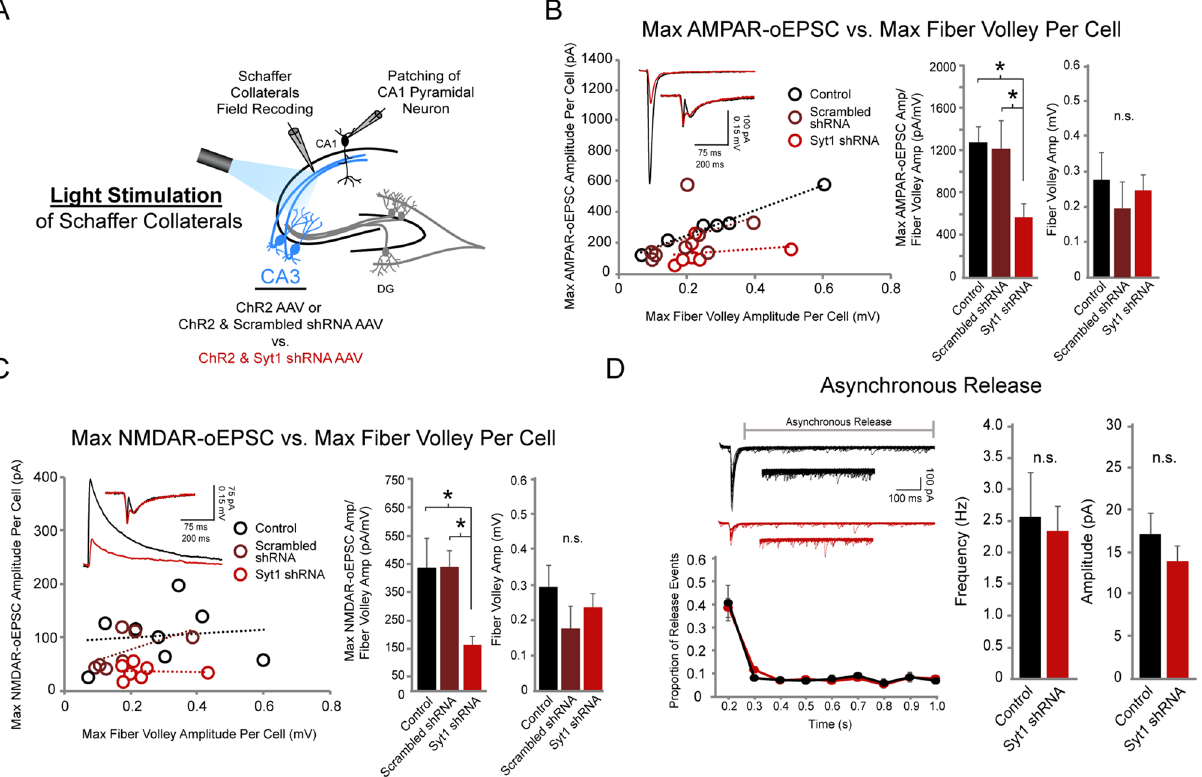
Figure 4. Syt1 knockdown diminishes CA3-CA1 excitatory synaptic transmission with optical stimulation of CA3 pyramidal neurons. ( A ) Schematic illustration of recording setup using optogenetic stimulation. AAV expressing: (1) ChR2 only (control), (2) ChR2 with scrambled shRNA (scrambled shRNA), or (3) ChR2 with Syt1 shRNA were injected into the CA3 region of hippocampal slices. Schaffer collaterals were optically stimulated with blue light. Schaffer collateral field recordings and whole-cell patch recordings of CA1 pyramidal neurons were simultaneously acquired. For ( B )–( D ), Wilcoxon rank sum test was used. * p < 0.05, n.s., not significant. ( B ) (Left) Max AMPAR-oEPSC/FV ratios per cell in control, scrambled shRNA & Syt1 shRNA conditions following optical stimulation. Each point represents the maximum AMPAR-oEPSC/FV amplitude ratio of one cell; measurements from each condition were fitted with a linear regression line. Insets show representative traces from control (black) and Syt1 shRNA (red) conditions. (Center) Averaged and normalized Max AMPAR-oEPSC/FV amplitude ratio in control, scrambled shRNA & Syt1 shRNA conditions (n = 6, 8, 7 respectively, control vs. Syt1 shRNA p = 0.007, scrambled vs. Syt1 shRNA p = 0.0037). (Right) Averaged fiber volley amplitudes in control, scrambled shRNA & Syt1 shRNA conditions (control n = 6, scrambled shRNA n = 8, Syt1 shRNA n = 7, control vs. Syt1 shRNA p = 0.63, scrambled vs. Syt1 shRNA p = 0.46). ( C ) (Left) Maximum NMDAR-oEPSC/FV ratios per cell in control, scrambled shRNA & Syt1 shRNA conditions. Insets show representative traces from control (black) and Syt1 shRNA (red) conditions. (Center) Averaged and normalized NMDAR-oEPSC/FV amplitude ratio in control, scrambled shRNA & Syt1 shRNA conditions (n = 8, 7, 7 respectively, control vs. Syt1 shRNA p = 0.022, scrambled vs. Syt1 shRNA p = 0.0023). (Right) Averaged fiber volley amplitudes in control, scrambled shRNA & Syt1 shRNA conditions (n = 8, 7, 7 respectively, control vs. Syt1 shRNA p = 0.46, scrambled vs. Syt1 shRNA p = 0.12). ( D ) Asynchronous release following optically-induced synchronous release in control (black) vs. Syt1 shRNA (red) conditions. (Left, Top) Representative traces, 10 sweeps of release events merged to show individual release events. (Left, Bottom) Proportion of release events over one second following initial optical stimulus. (Right) Frequency and amplitudes of asynchronous release events in control vs. Syt1 shRNA conditions (n = 6 each condition, both frequency and amplitude, p = 0.9372 and 0.4848